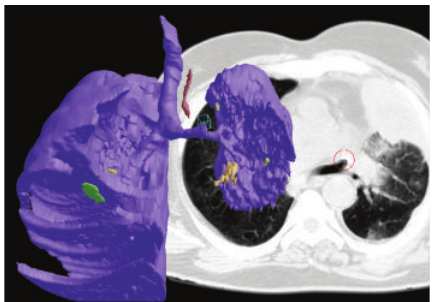
Figure 7: Small left lung after lobectomy and atelectasis of the remnant lobe due to alveolar collapse by pleural fluid collection and alveolar consolidation. There is no significant mediastinal shift toward the involved side, and the branches of the left pulmonary artery are